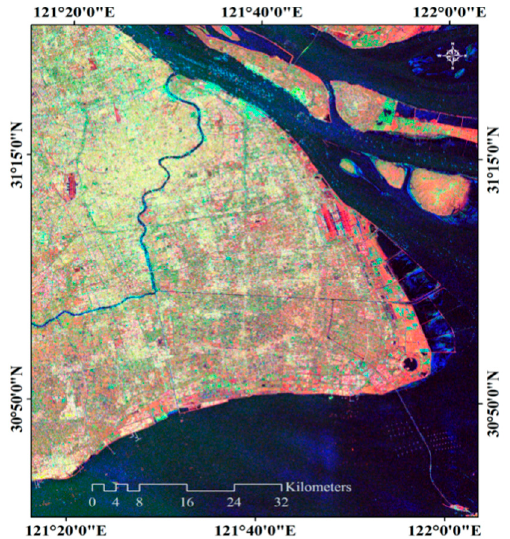
Figure 2. Shanghai coherence false color image (the acquisition dates are 27 February 2017 and 11 March 2017, respectively). The red channel is coherence. The green channel is mean backscattering intensity. The blue channel is backscattering intensity difference. The spatial resolution is 30 m × 30 m).